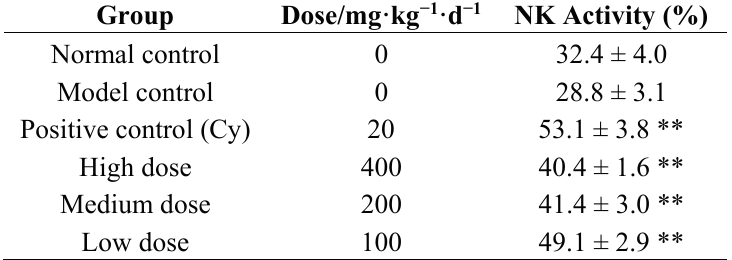
Table 7. Effect of BBP3-1 on mouse NK cell activity in vitro ( x ± s, n =